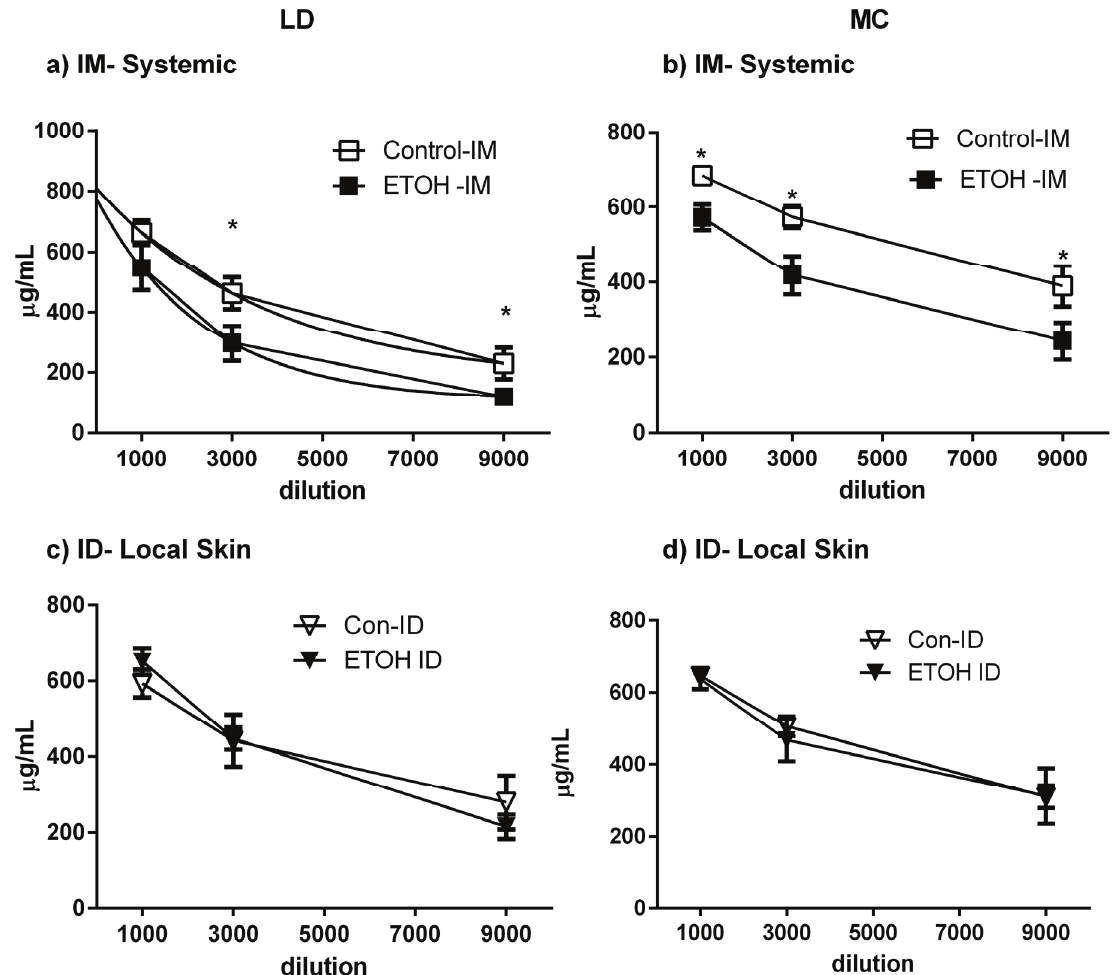
Figure 5. Skin Immunization Obviates EtOH Induced Inhibition of Vaccine Induced IgG. Mice fed ETOH by LD ( a , c ) or MC ( b , d ) protocols and EtOH-naïve controls were immunized with influenza vaccine by IM ( a , b ) or ID ( c , d ) routes and boosted on day 21 ( n = 3–8). Total antigen-specific IgG, as determined by Elisa, is shown, with * p <